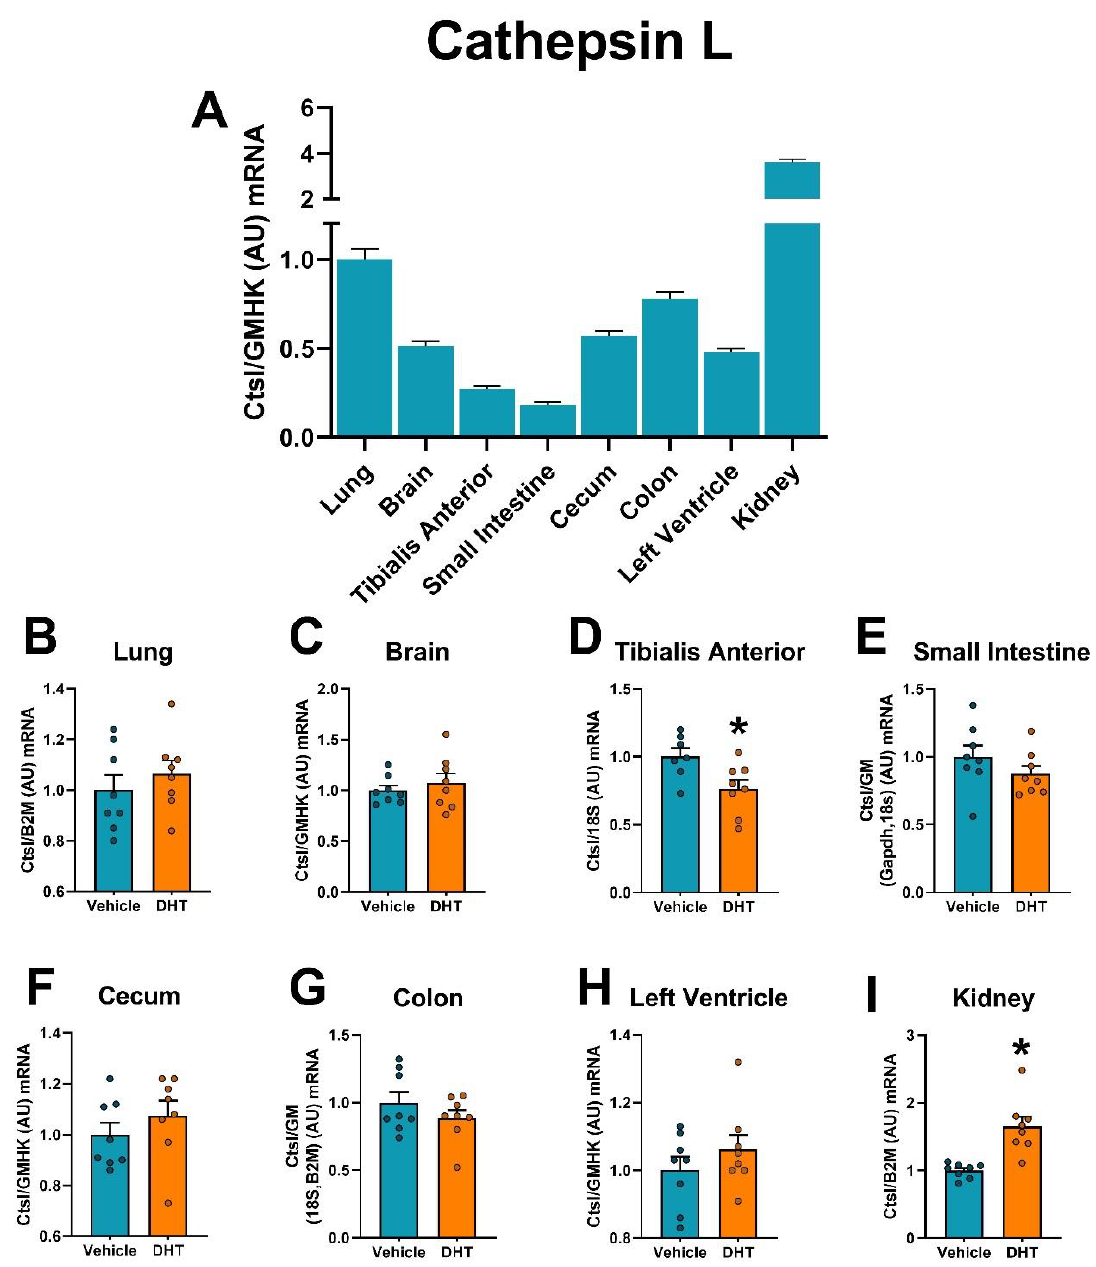
Figure 8. Cathepsin L mRNA expression regulation by DHT in different tissues. Cathepsin L mRNA expression was quantified by RT-qPCR. ( A ) Cathepsin L mRNA expression in control mice normalized to the geometric mean of all reference genes and expressed relative to lung tissue. ( B – I ) Cathepsin L mRNA expression in the lung ( B ), brain ( C ), tibialis anterior ( D ), small intestine ( E ), cecum ( F ), colon ( G ), left ventricle ( H ), and kidney ( I ) of control and DHT-treated mice normalized to the least variable reference gene or set of them and expressed relative to control mice. Data analyzed by t-test. n = 7–8/group. *: p < 0.05.